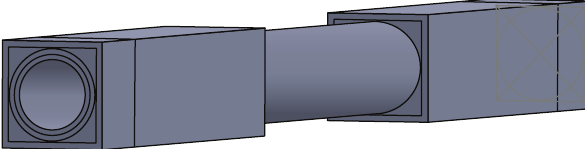
Figure 8: 3D model of FE